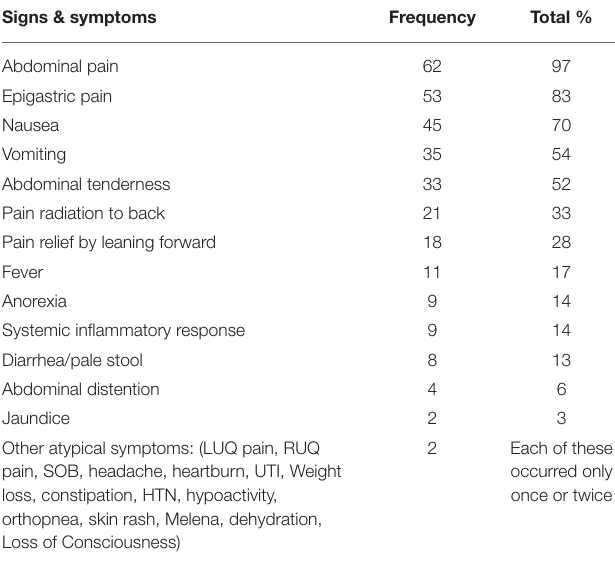
TABLE 2 | Clinical features of acute pancreatitis in our cohort at presentation (Considering all the acute pancreatitis episodes).